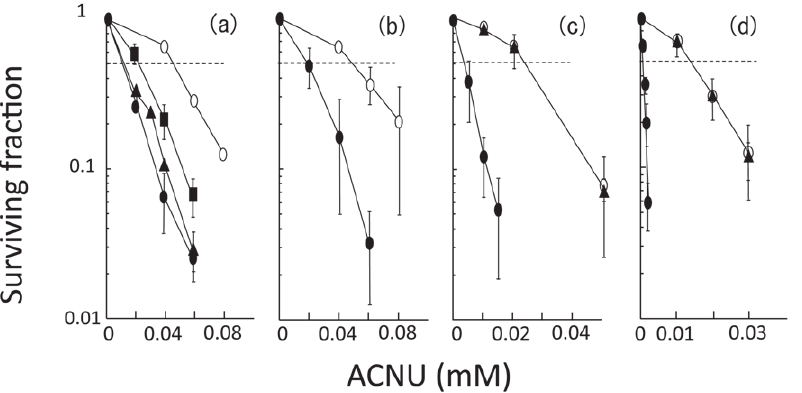
Figure 1. Sensitivity to ACNU. a , FANCwt cells (open circles), FANCA 2 / 2 C 2 / 2 cells (closed triangles), FANCC 2 / 2 cells (closed squares), and FANCA 2 / 2 cells (closed circles); b , FANCwt cells (open circles) and FANCD2 2 / 2 cells (closed circles); c , FANCGwt cells (open circles), FANCGrev cells (closed triangles), and FANCG 2 / 2 cells (closed circles); d , FANCD1wt cells (open circles), FANCD1rev cells (closed triangles), and FANCD1mt cells (closed circles). Each point represents the mean of three independent experiments; bars indicate the SD.